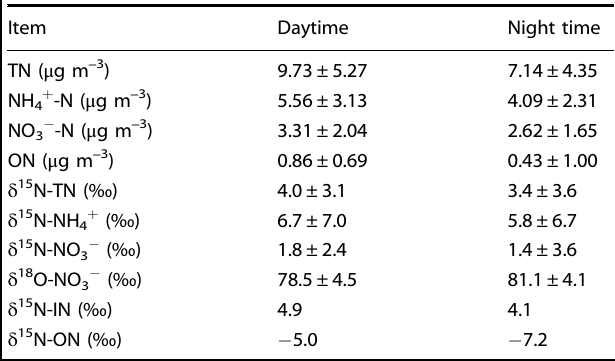
Fig. 1 The concentrations of NH 4 + -N, NO 3 − -N and organic nitrogen (ON) in daytime and nighttime total suspended particles over Mt. Tai in spring 2017. The concentrations of ON in some samples were very low and under the detection limit, we approximate them by 0. Table 1. Statistics (average ± standard deviation) of the concentrations of daytime and nighttime total nitrogen (TN), inorganic nitrogen (IN: NH 4 + -N, NO 3 − -N) and organic nitrogen (ON), and corresponding isotopic compositions in total suspended particles over Mt. Tai in spring